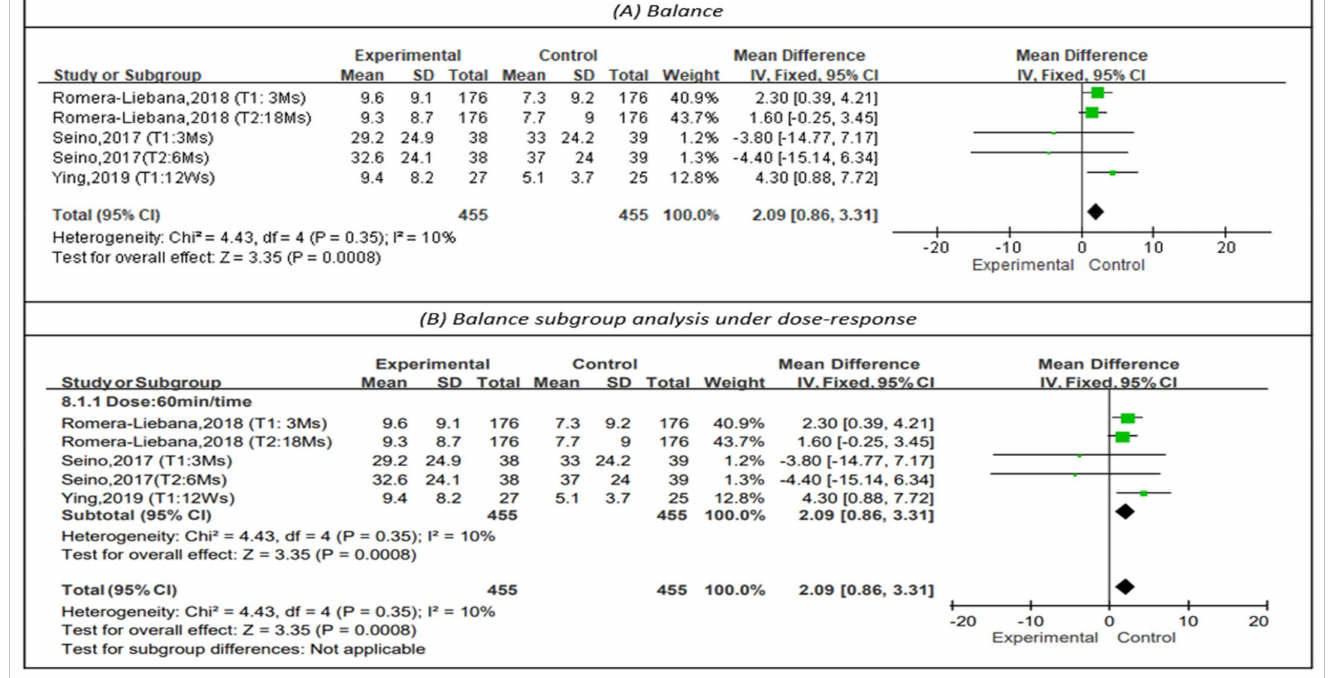
Figure 7. Forest plot of effects on balance and subgroup analysis for dose-response. The size of the green square represents the weight of the study in the meta-analysis. The rhombus represents the combined OR. OR = odds